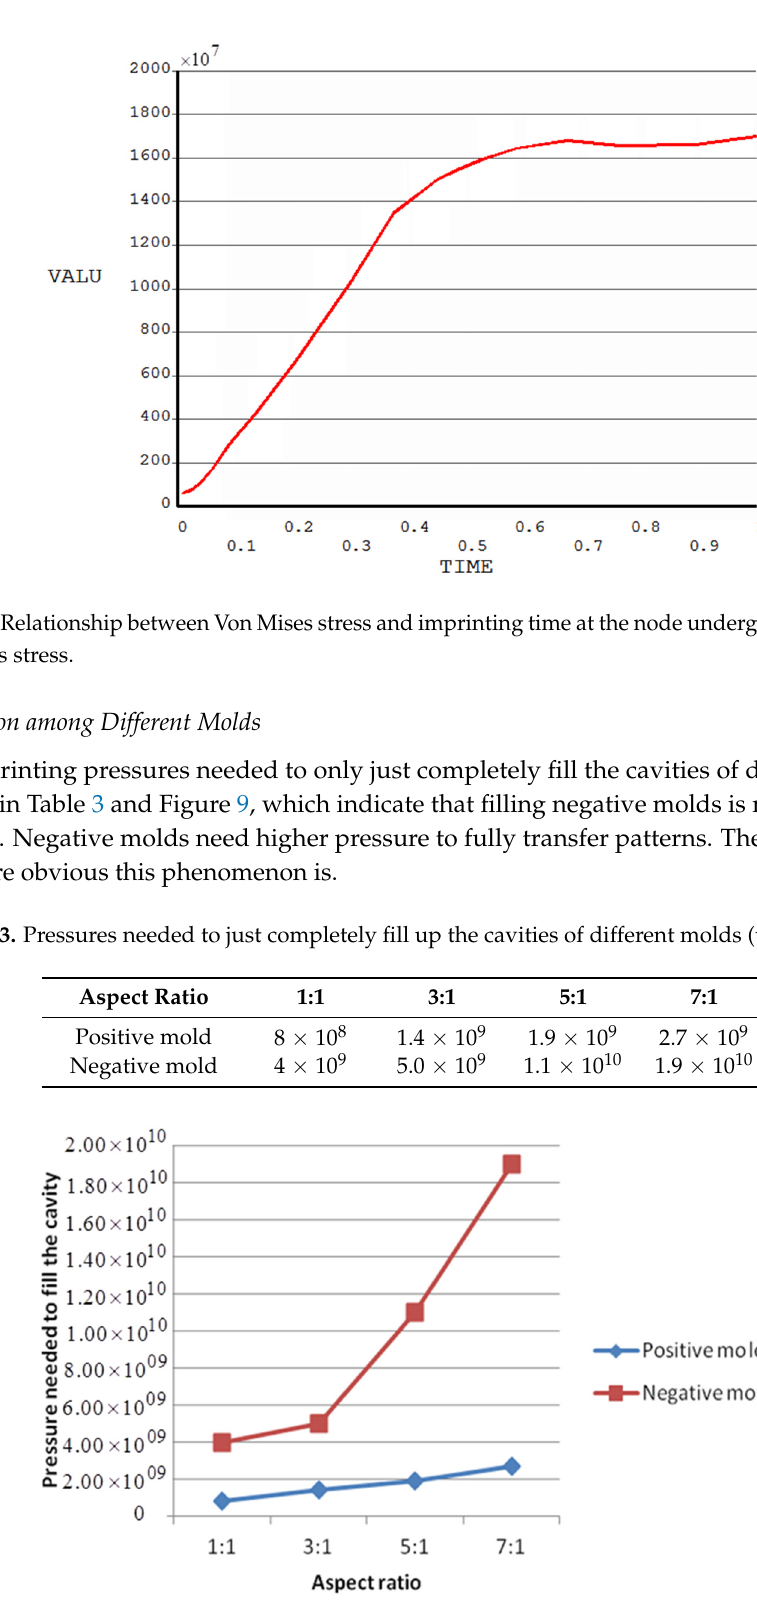
Figure 9. Relationship between pressures needed to fill cavities and different aspect ratios for both positive and negative molds (units of Pa).